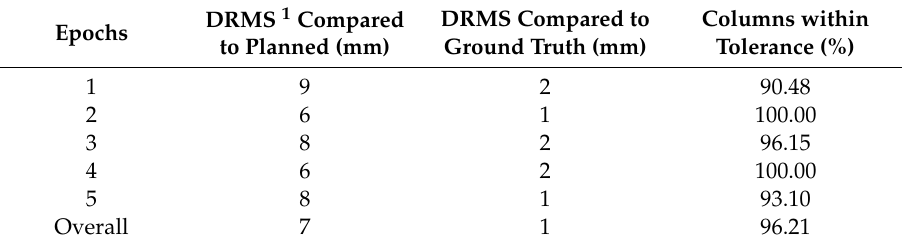
Table 5. Accuracy assessment of column cross-section